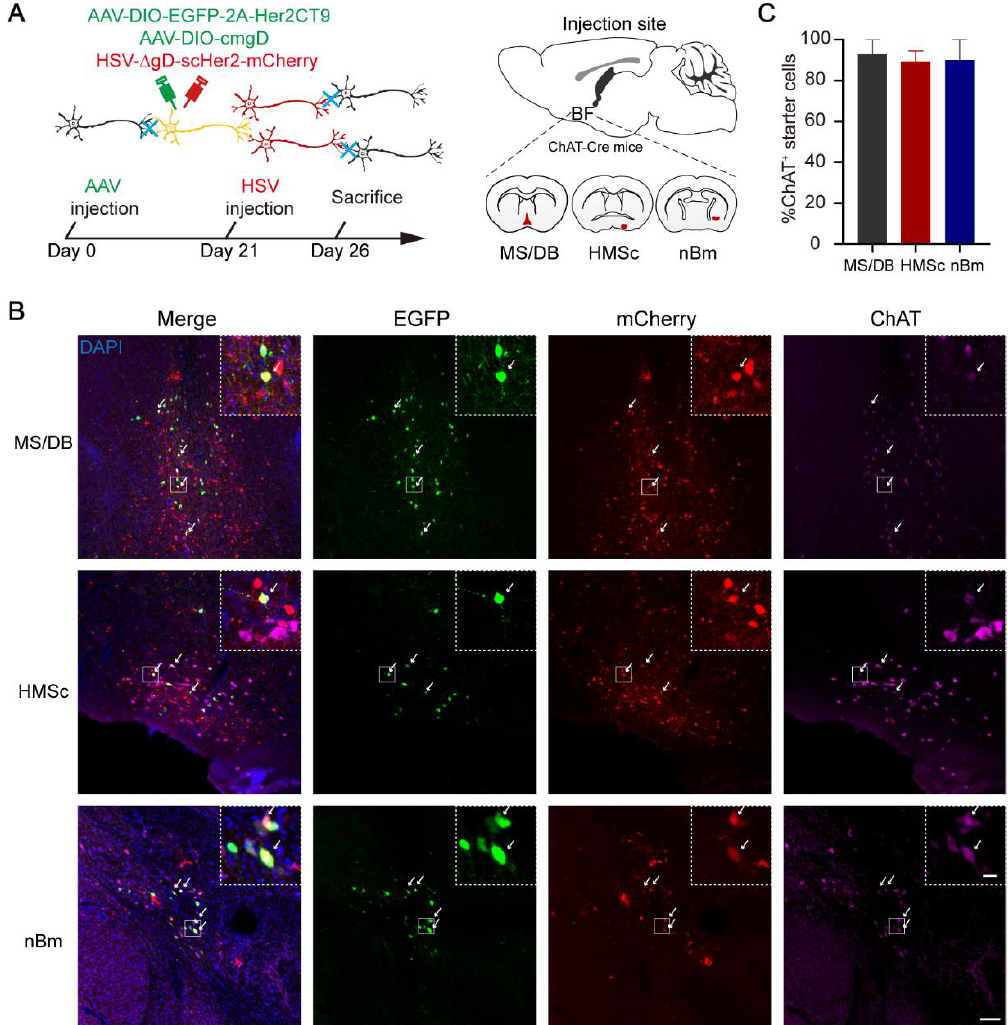
Figure 1. Anterograde monosynaptic tracing. ( A ) Structure (top), time-course of injection (bottom), and injection site (right) of the anterograde monosynaptic virus. ( B ) Representative image of the starter cells in MS/DB (top), HMSc (middle), and nBm (bottom). Enlarged views of starter cells in the top right corner of each image in the first column. Merge image (first column), EGFP (green, second column), mCherry (red, third column), and anti-ChAT immunofluorescence staining (pink, last column) are shown separately. The starter cells labeled by rAAV (EGFP), HSV (mCherry), and anti-ChAT immunofluorescence staining (pink) are indicated by white arrows. Nuclei were detected by DAPI (blue) staining. ( C ) The percent of cholinergic starter cells. MS/DB included MS and vDB; HMSc included HDB, SI, and MCPO. n = 4 mice in MS/DB group, n = 3 mice in HMSc group, n = 3 mice in nBm group. Scale bar, 100 μm ; 20 μm for insets.